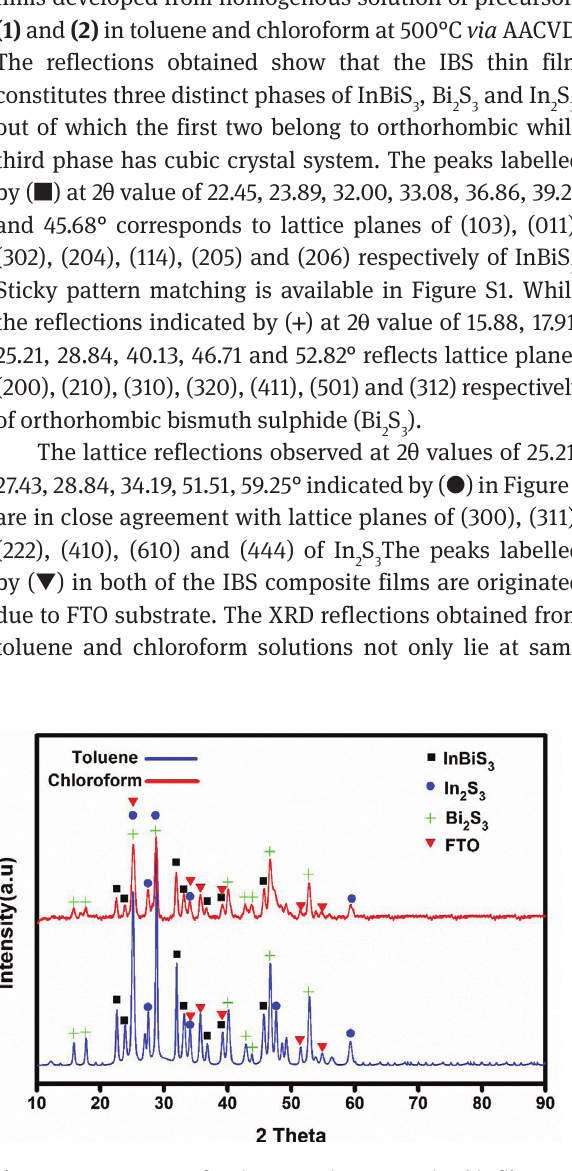
Figure 1: XRD pattern of InBiS fabricated on FTO substrate at 500°C from homogenous solutions of precursors (1) and (2) in toluene (blue) and chloroform